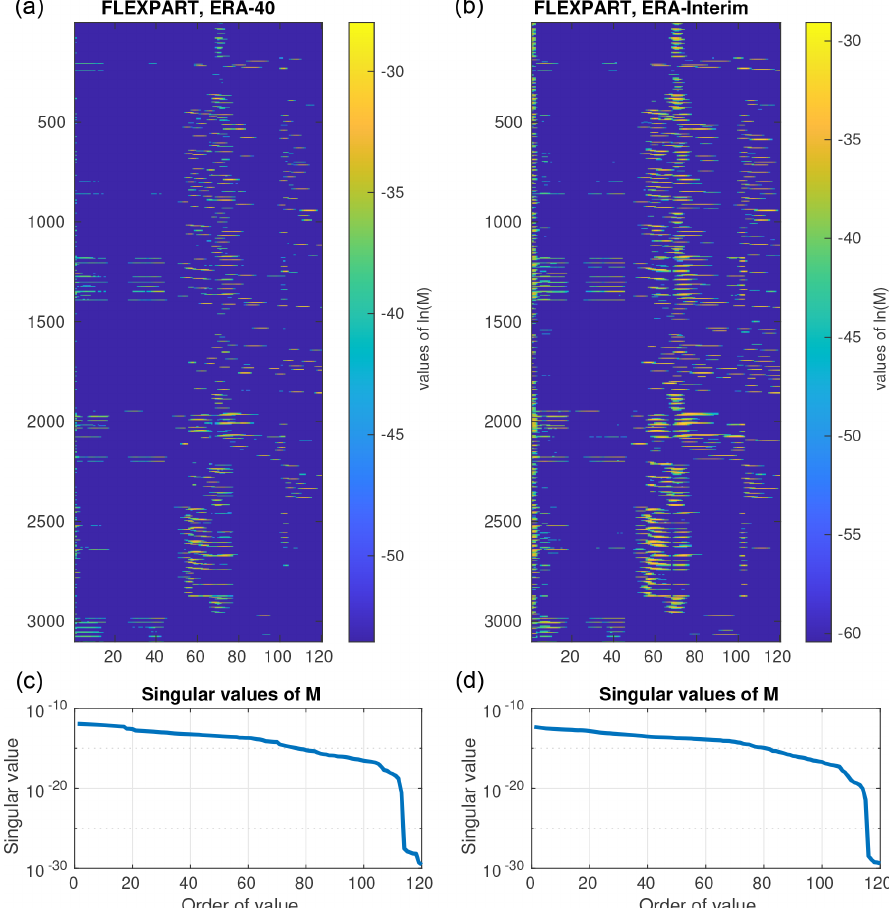
Figure C1. ETEX SRS matrices computed using FLEXPART driven by meteorological input data from the European Center for Medium- Range Weather Forecasts (ECMWF). (a, c) Data from the 40-year reanalysis (ERA-40) and (b, d) data from the continuously updated ERA-Interim reanalysis. The matrices are associated with their singular values (bottom